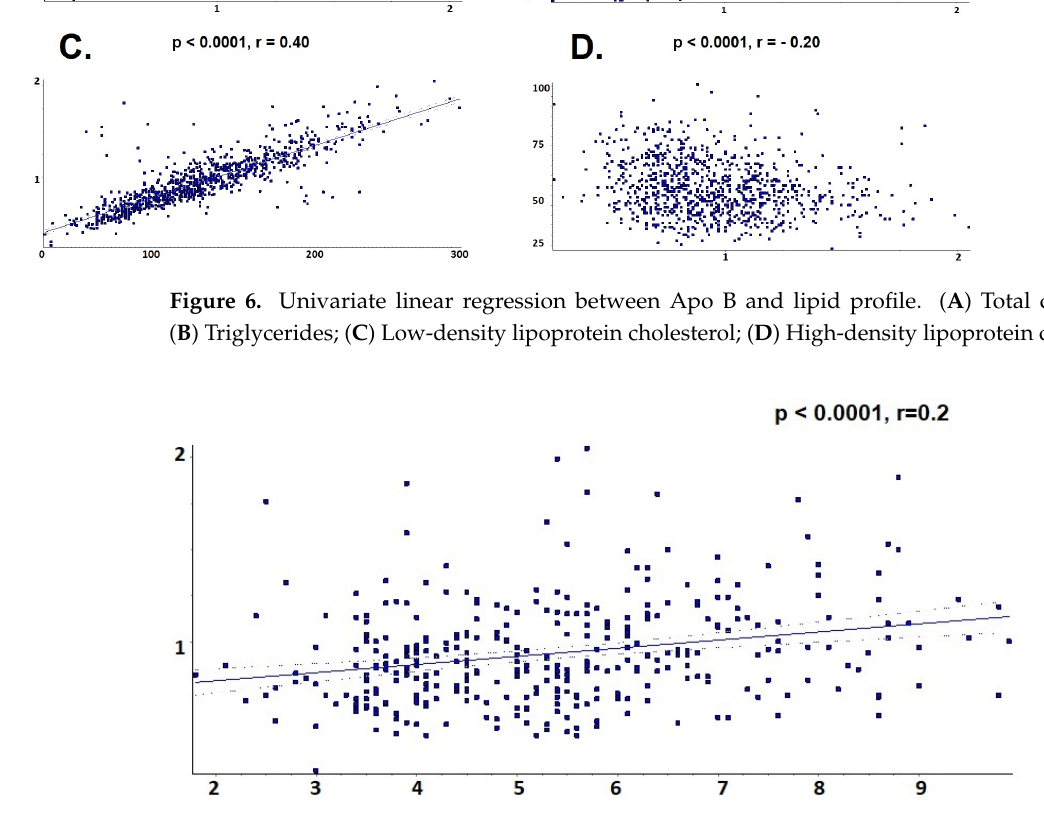
Figure 7. Univariate linear regression between Apo B and uric acid .